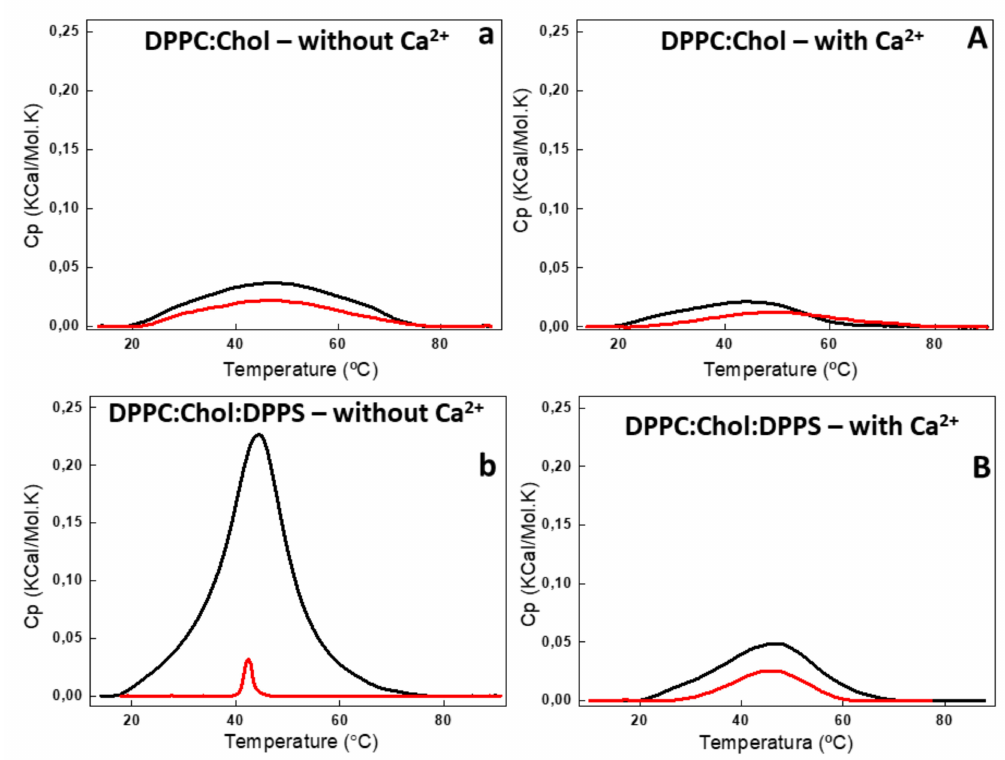
Figure 4. DSC thermograms of 6:4 DPPC:Chol ( a , A ) and 5:4:1 DPPC:Chol:DPPS ( b , B ) liposomes (10 mg / mL, total lipid concentration) in the absence (lower case) and in the presence (capital letter) of 2 mM Ca 2 + . DSC thermograms were processed in excess heat capacity (C p ) (kcal / K.mol) as function of temperature ( ◦ C) of liposomes (black) and AnxA6-harboring proteoliposome (red).